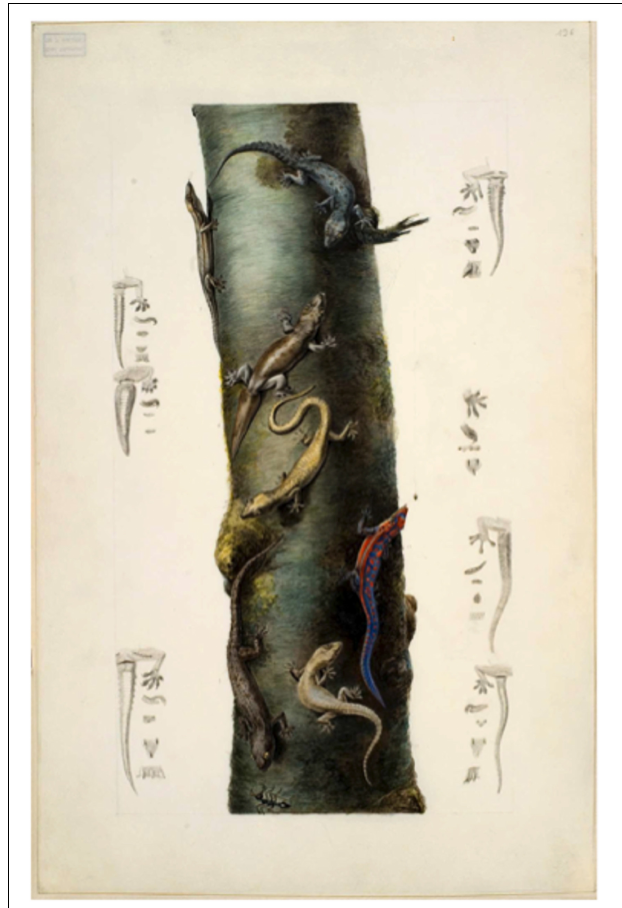
FIGURE 1 | An image of seven geckos drawn by Charles Alexandre Lesueur in 1803. The Hemidactylus parvimaculatus from Coëtivy is bottom right (Cheke, 2009). Although it is a female without preano-femoral pores, the pattern of tubercles and the undertail scalation detailed in the side-sketch closely match photographs and details for parvimaculatus in Mahony’s (2011) review of brookii group